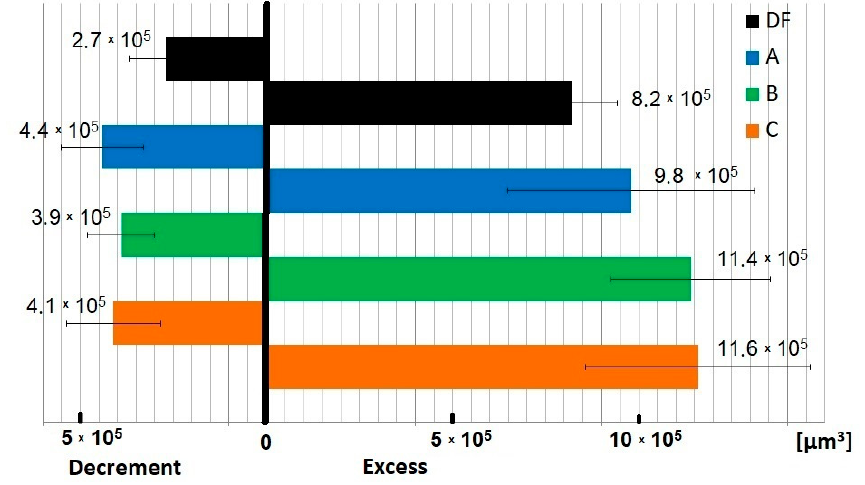
Figure 6. Results of fretting wear measurement, accounting for volumes of material decrement and excess (p = 30 MPa).